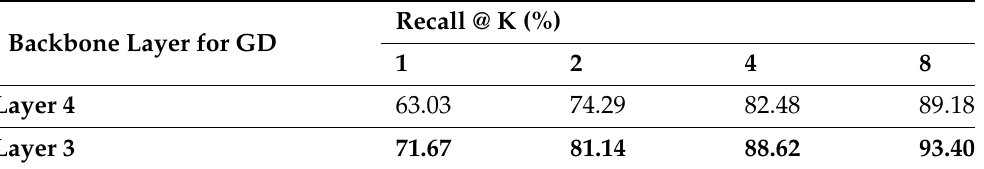
it is the same for the row ‘Layer 3’. The bold values are the best performances in each recall @ K. Backbone Layer for GD